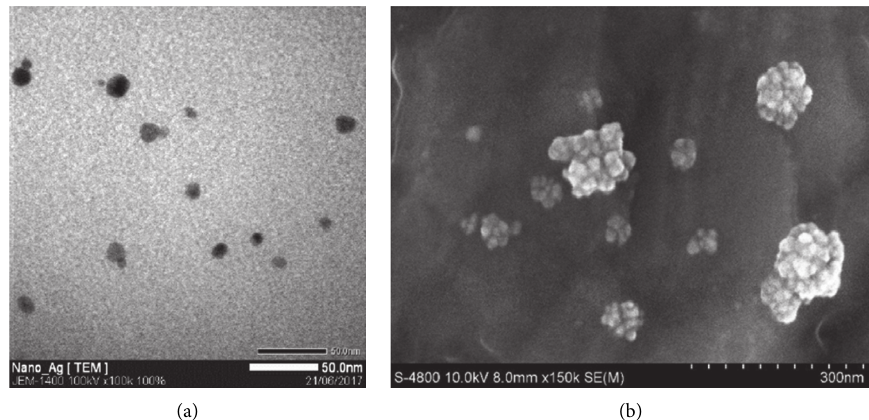
Figure 3: (a) TEM image of AgNPs/PPE and (b) SEM image of AgNPs clusters after precipitated together with pectin from PPE.